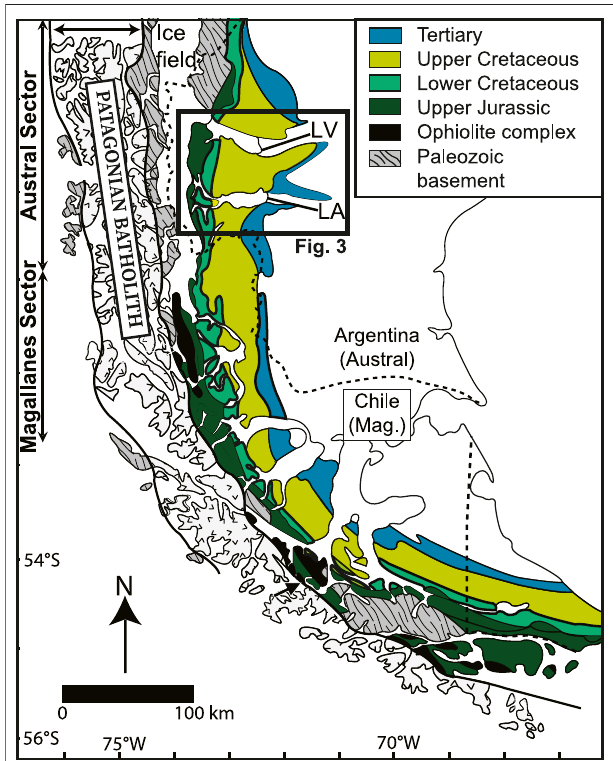
FIGURE 2 | (A) Overview geologic map of the Jurassic through Cenozoic outcrop belt of the Magallanes-Austral Basin in southern South Americamodi fi edfromMalkowskietal.(2017a).LA,LagoArgentino;LV,Lago Viedma; Mag, Magallanes. Dashed line is the Chile (Magallanes sector)- Argentina (Austral basin sector) boundary. Black rectangle outlines location of Figure 3 .